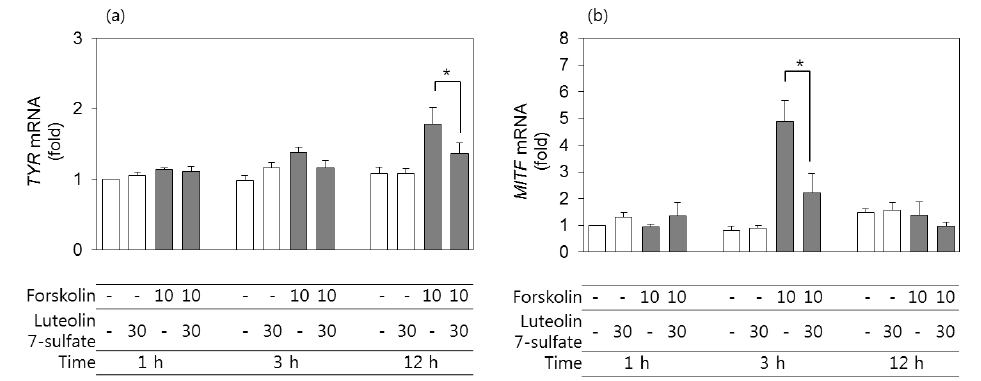
Figure 3. Effects of luteolin 7-sulfate on the mRNA levels of tyrosinase ( TYR ) and microphthalmia-associated transcription factor ( MITF ). B16-F10 cells were pretreated with 30 μM luteolin 7-sulfate and stimulated with 10 μM forskolin for 1, 3, and 12 h. The mRNA levels of MITF ( a ) and TYR ( b ) were determined by quantitative reverse transcription polymerase chain reaction and normalized with respect to glyceraldehyde 3-phosphate dehydrogenase. The means ± SEs of three independent experiments are presented. * p < 0.05.